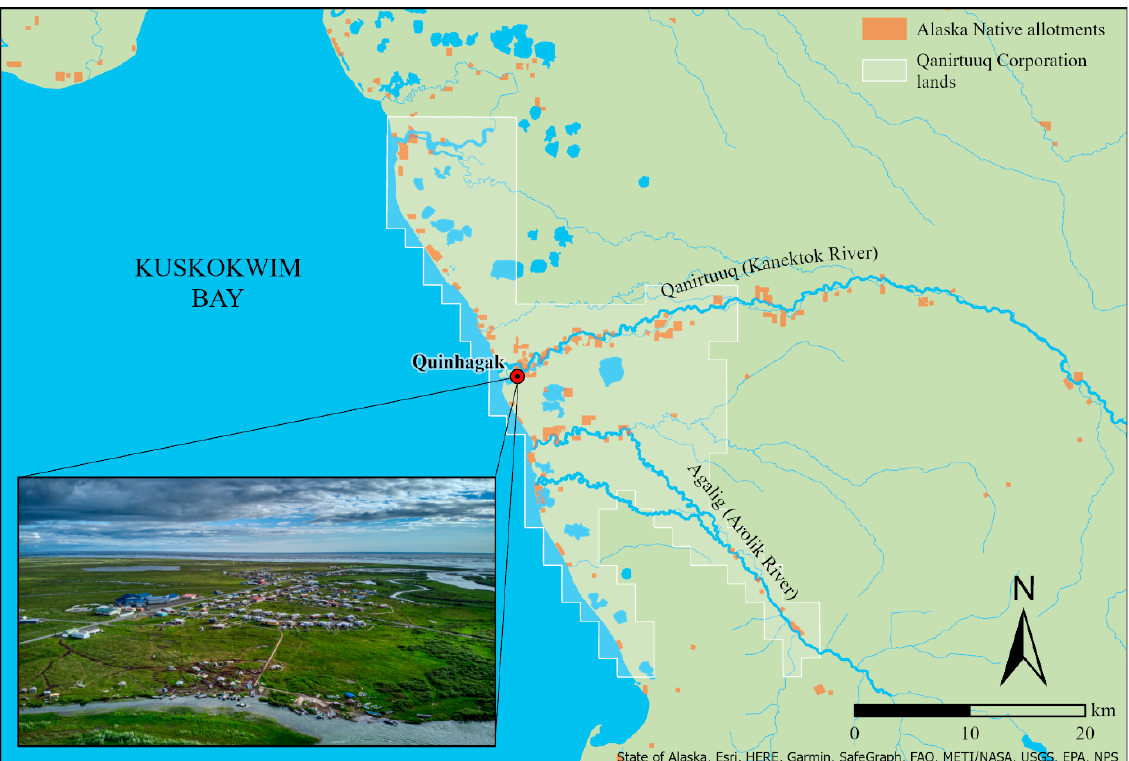
Figure 2. Quinhagak is a traditional Yup’ik village of around 700 people on the Bering Sea (see inset aerial photo). Exact sample area locations are not shown to protect archaeological site locations.